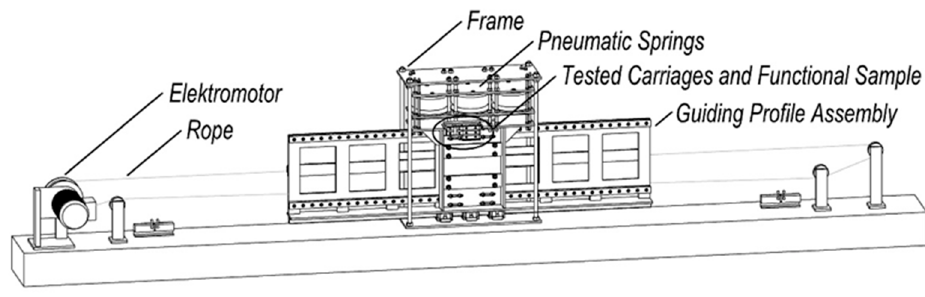
Figure 4. The model of the testing facility.